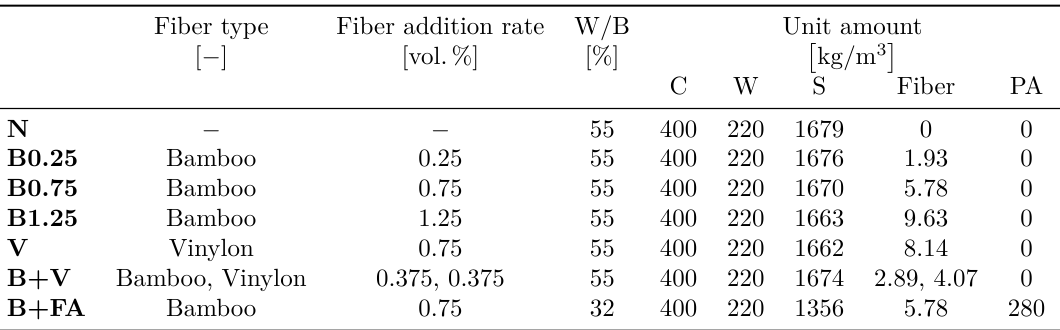
Table 2. Mix proportions of mortar in laboratory test.